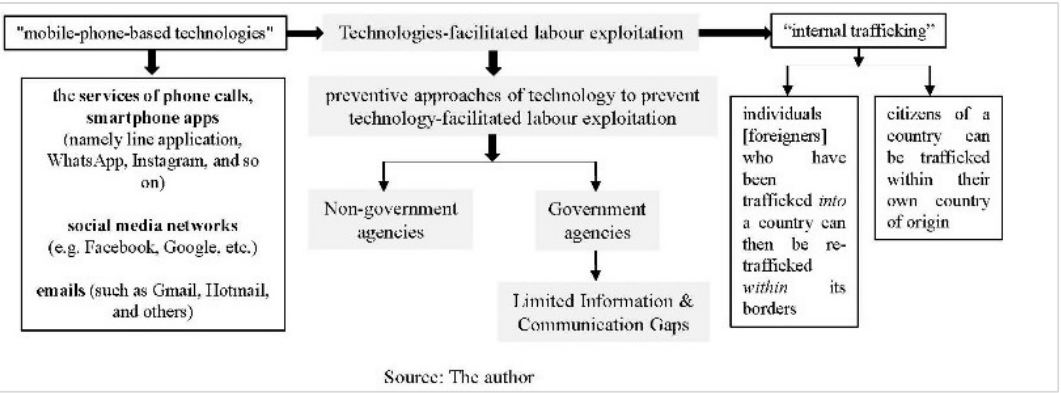
Figure 1. Technology-facilitated forced labor exploitation and limited information and communica- tion gaps.